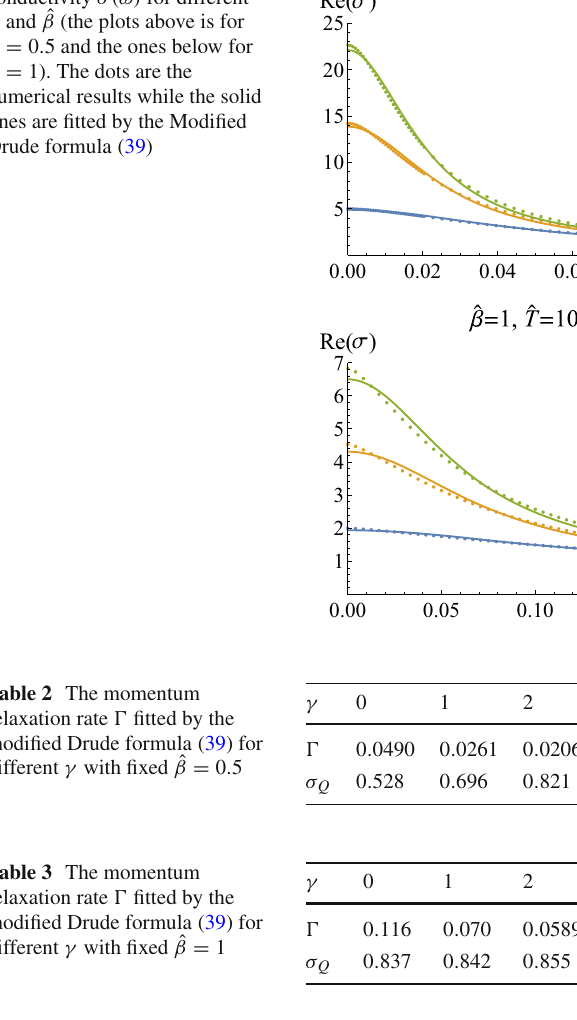
Fig. 8 (cid:19)(cid:18) as the function of γ with different ˆ β at the temperature ˆ T = 10 − 3